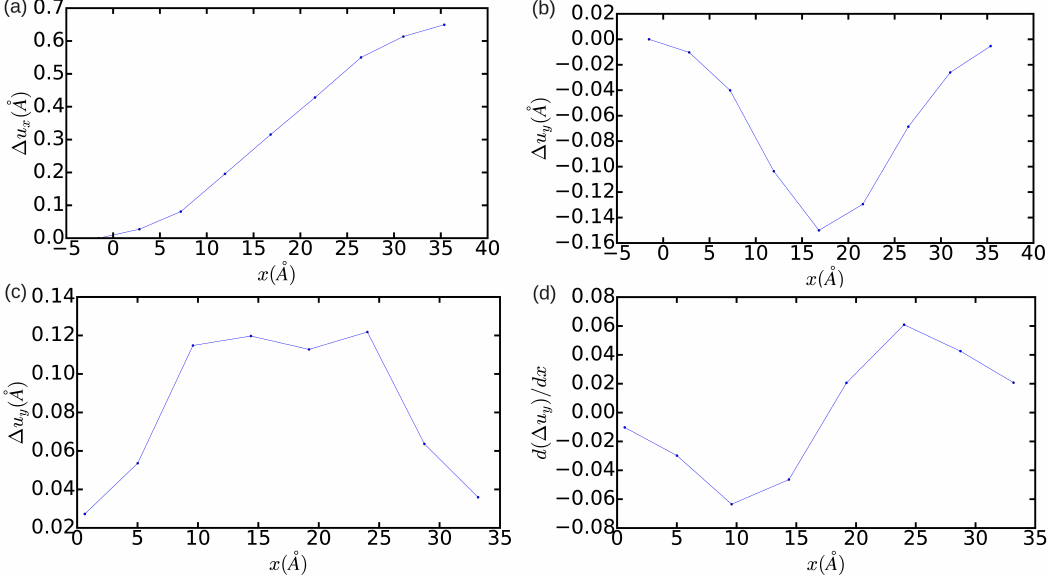
Figure 4. Relative displacement ( a , b ) and differential displacement ( c , d ) of the atoms above and below the glide plane of the edge dislocation in the x - and y -directions. The simulation cell contains n = 1368 atoms and is fully